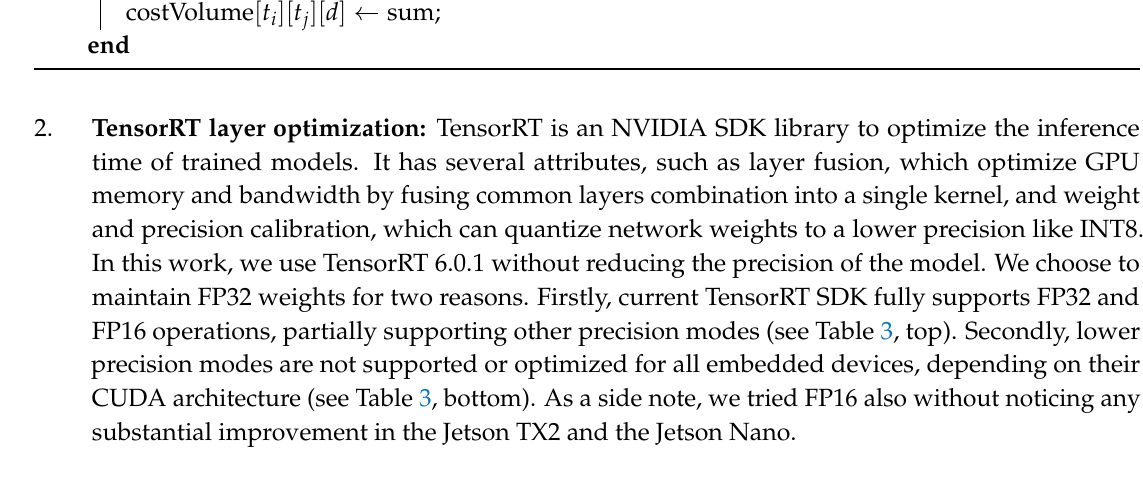
Table 3. On the top subtable, a list of available layers in the evaluated models and their support in TensorRT 6.X SDK. On the bottom subtable, a list of supported precision modes for the different embedded graphic processing unit (GPU) devices used in this